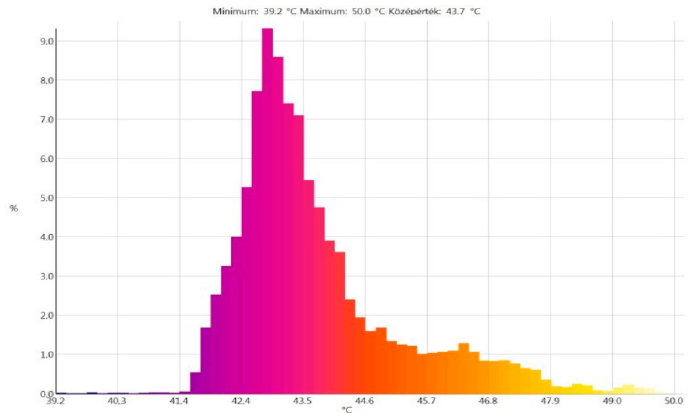
Figure 4. Histogram of the surface temperatures (external transparent wall – February 2020).